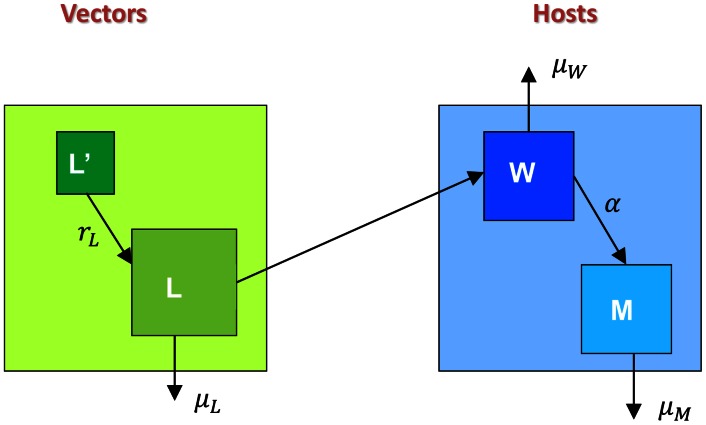
Basic structure of the LF model.See Tables 1 and 2 for a summary of state variables and parameters.